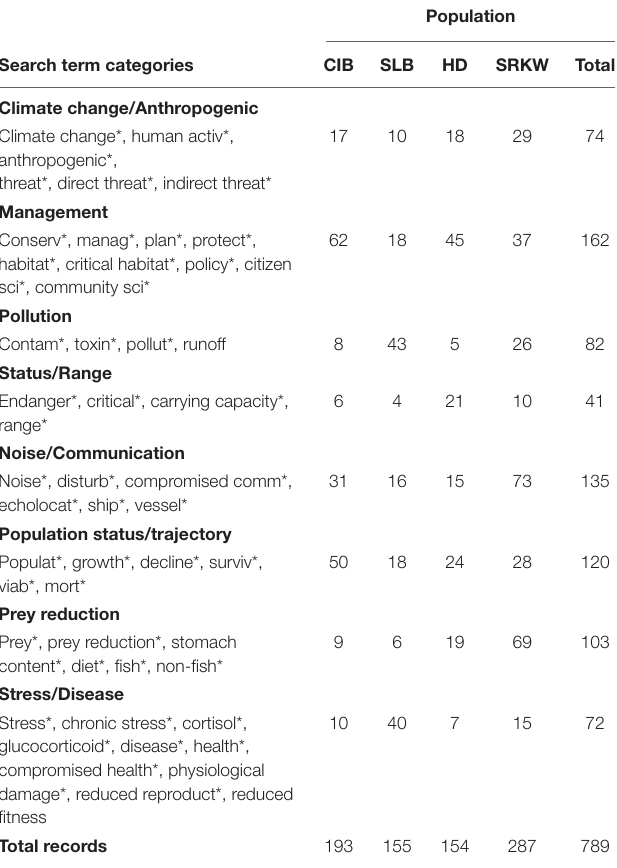
TABLE 3 | Number of records (1975-May 2021) by search term category and population [Cook Inlet beluga (CIB), St. Lawrence beluga (SLB), southern resident killer whale (SRKW), and Hector’s dolphin